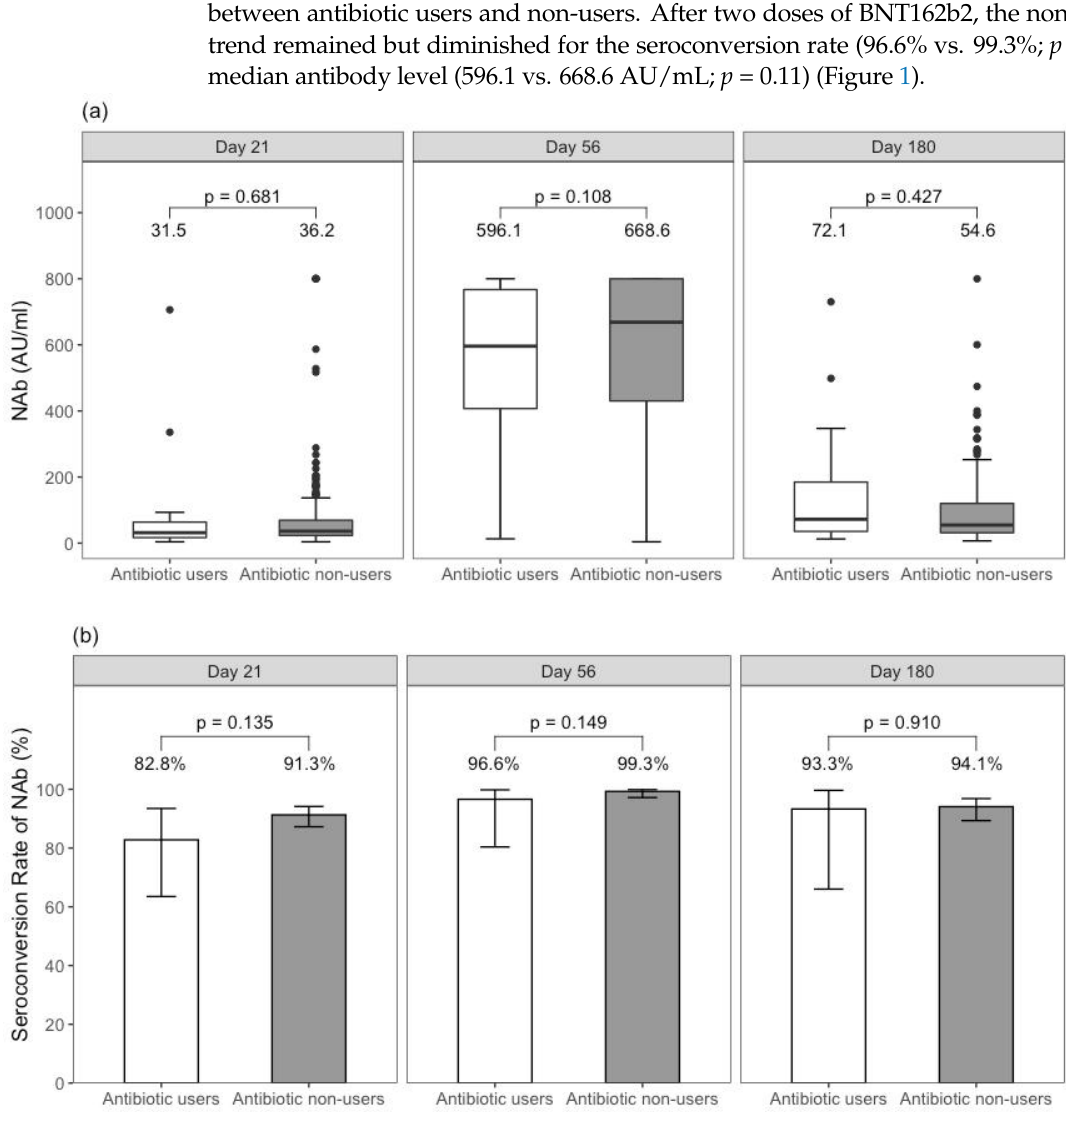
Figure 1. Comparison of ( a ) neutralising antibody level and ( b ) seroconversion rate between antibiotic users and non-users among BNT162b2 recipients. Note: 316 subjects had neutralising antibody level measured at day 21, 284 subjects at day 56, 185 subjects at day 180.